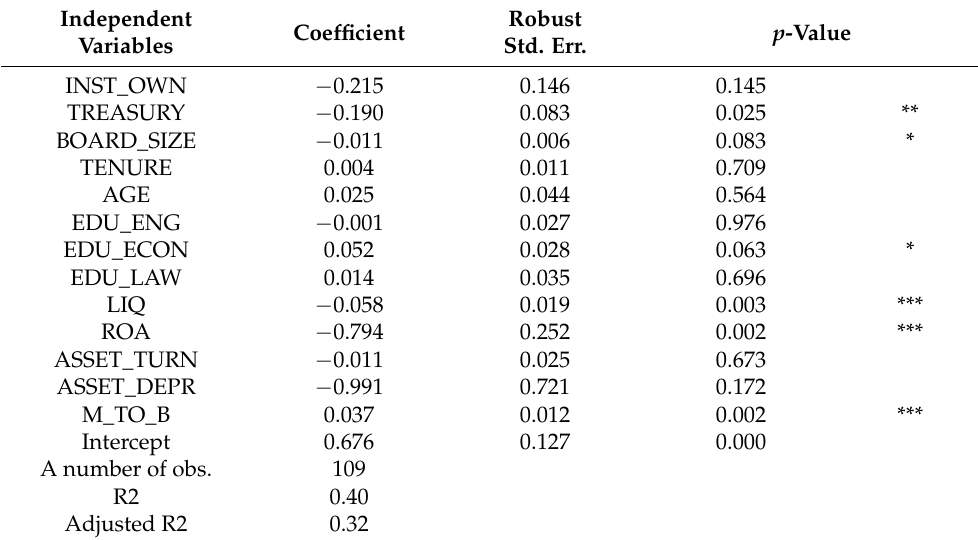
Table 4. Results of the regression analysis.